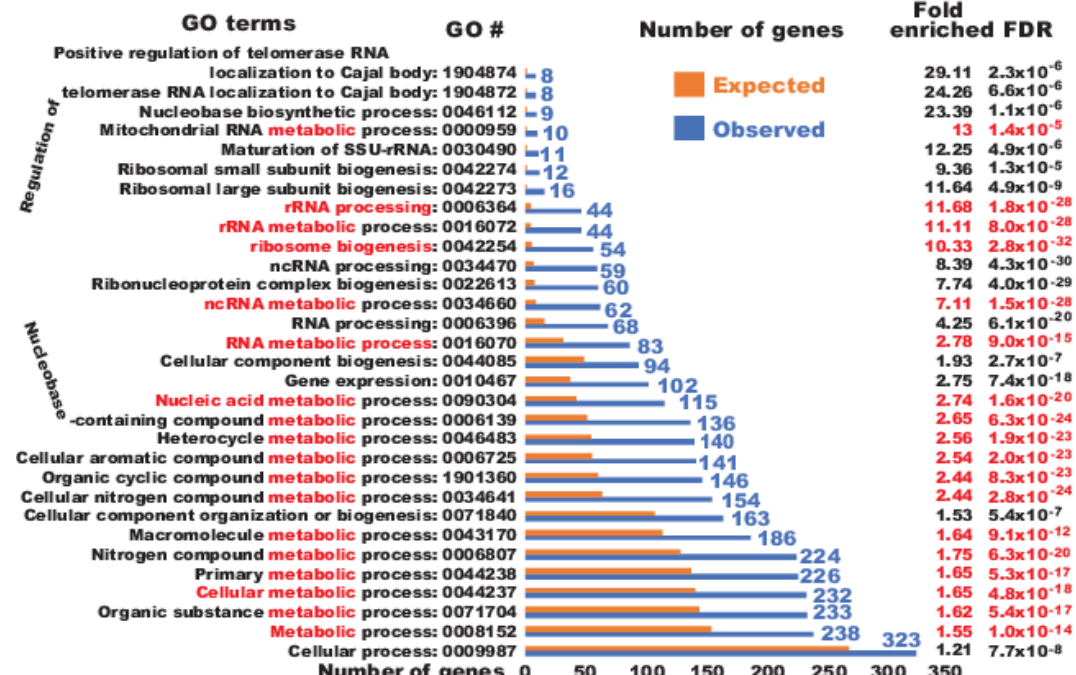
Figure 2. Genes involved in nucleic acid metabolisms were predominant among the early successfully reprogrammed genes. Shown is a summary of the analyses of the 366 properly reprogrammed genes with the GO annotation database of “GO biological process”. GO terms with the “metabolic” keyword and their statistical results are highlighted in red except for the numbers of genes observed for each GO term, which are all in blue. Expected numbers of genes for each GO term are not given due to space limit.